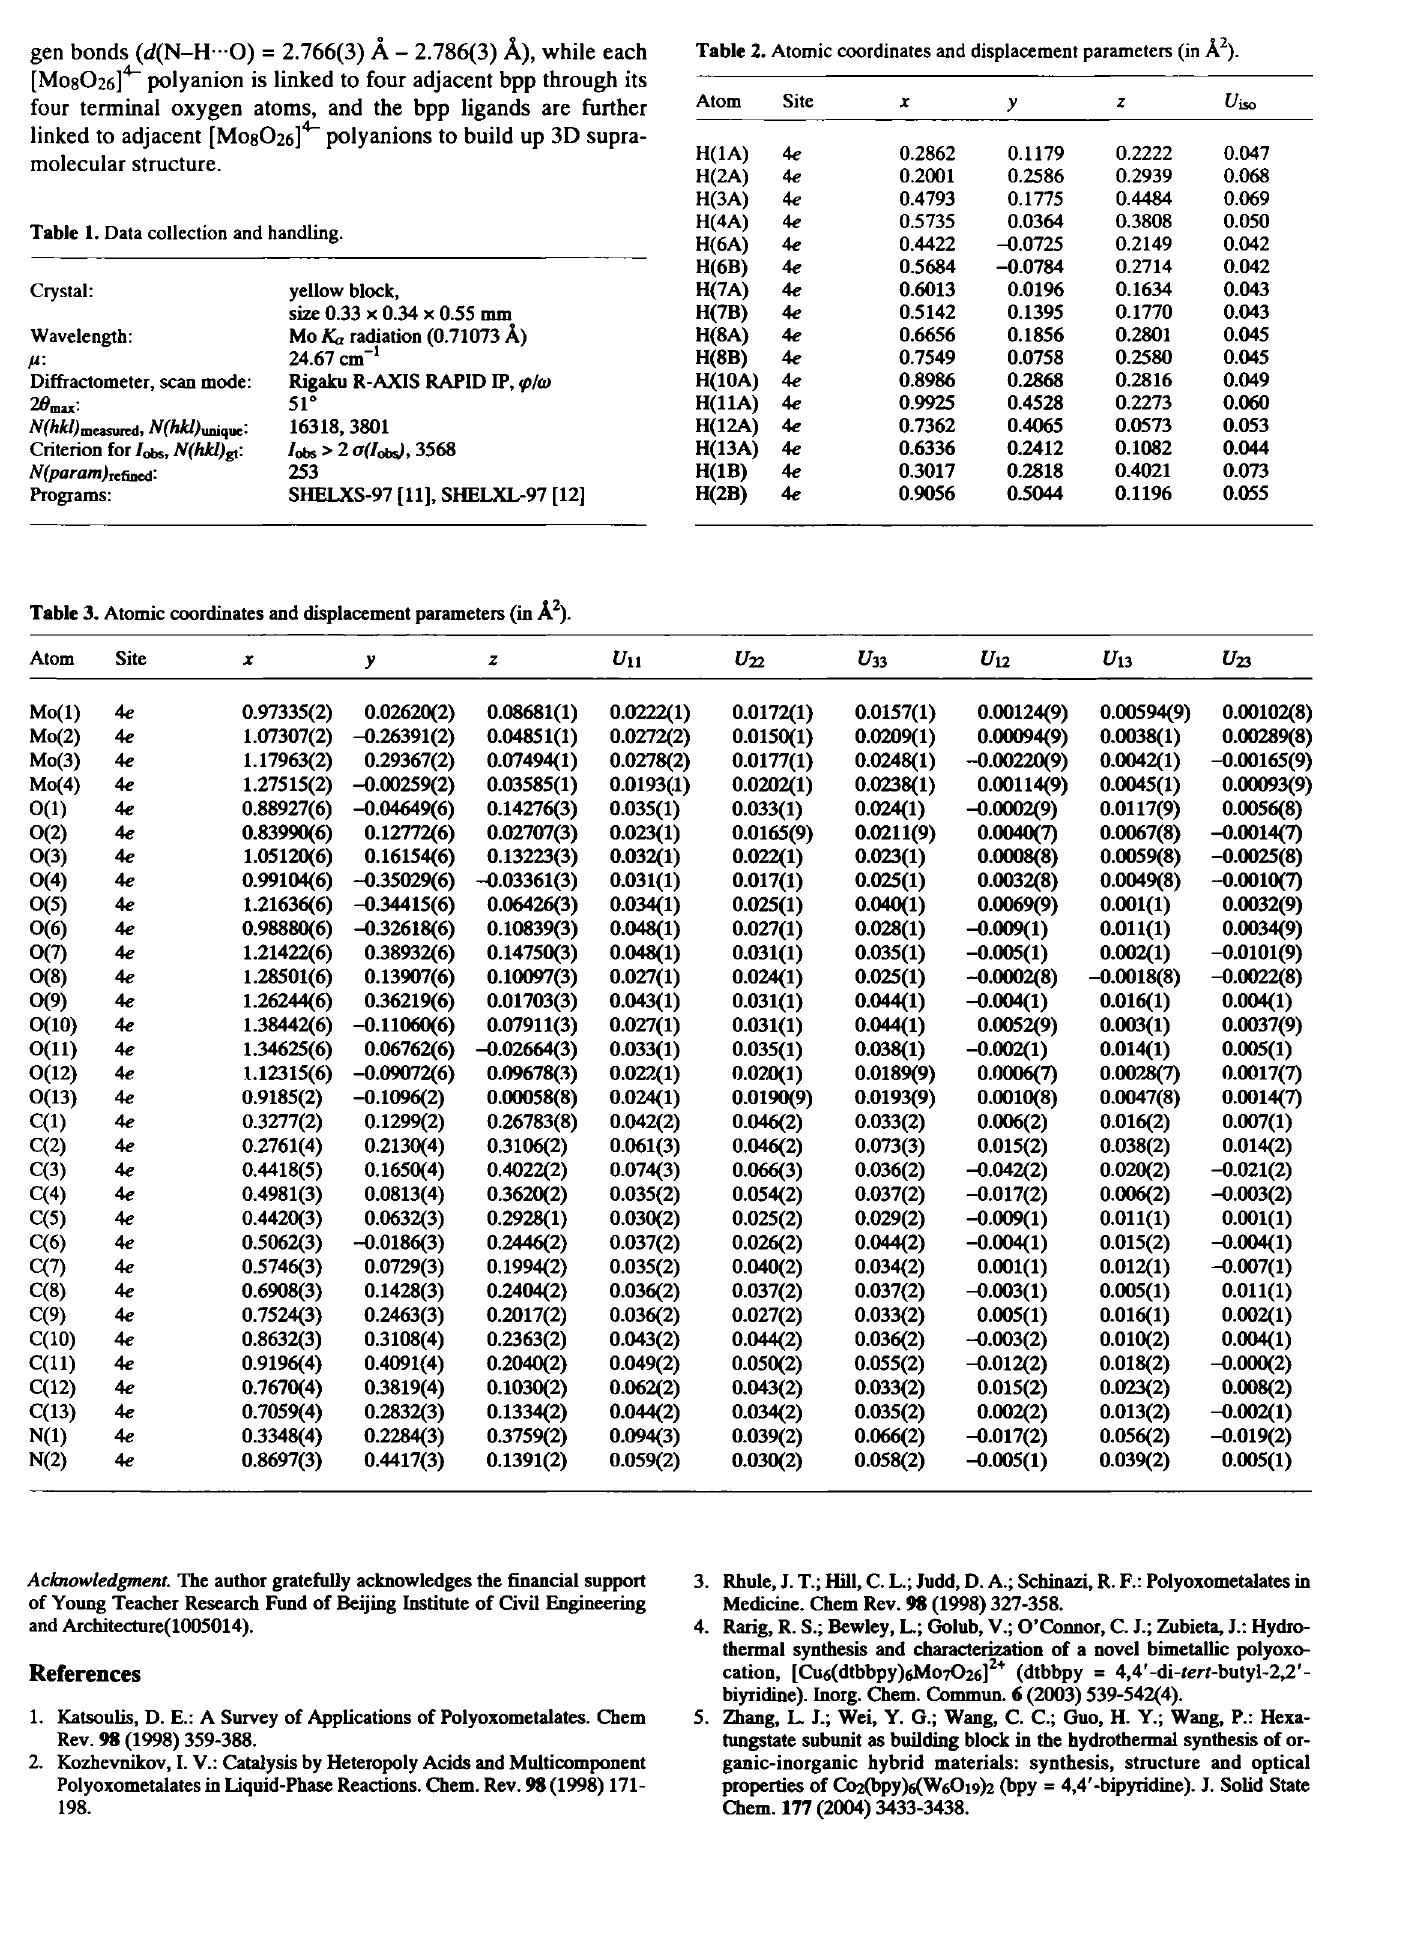
Table 1. Data collection and handling.